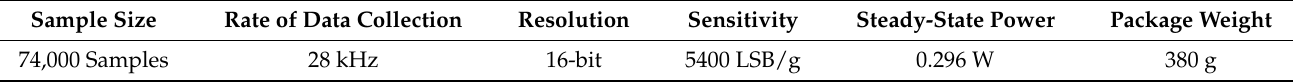
Table 1. Summary of the sensor package features.